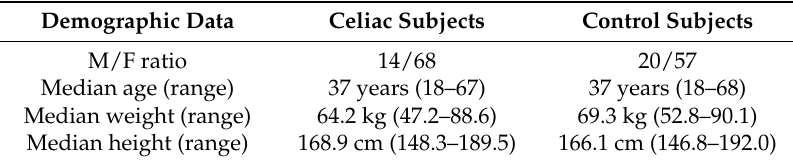
Table 1. Demographics of celiac and control participants.